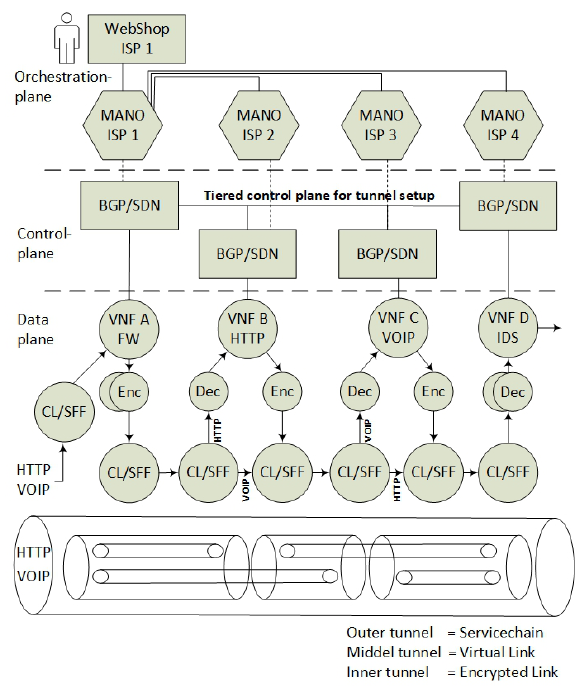
Figure 5. The architectural